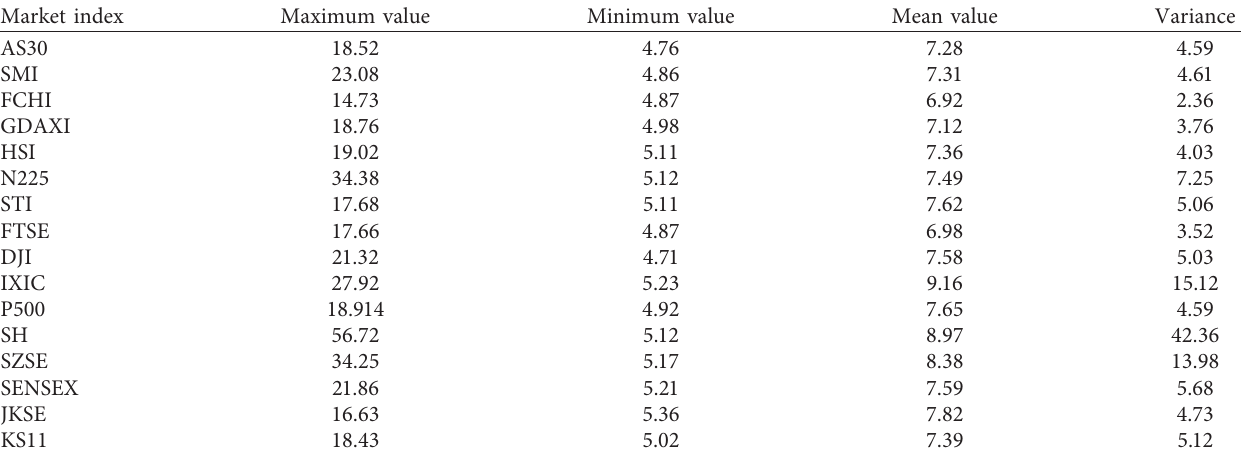
Table 1: EMD distance statistics data of each market index.